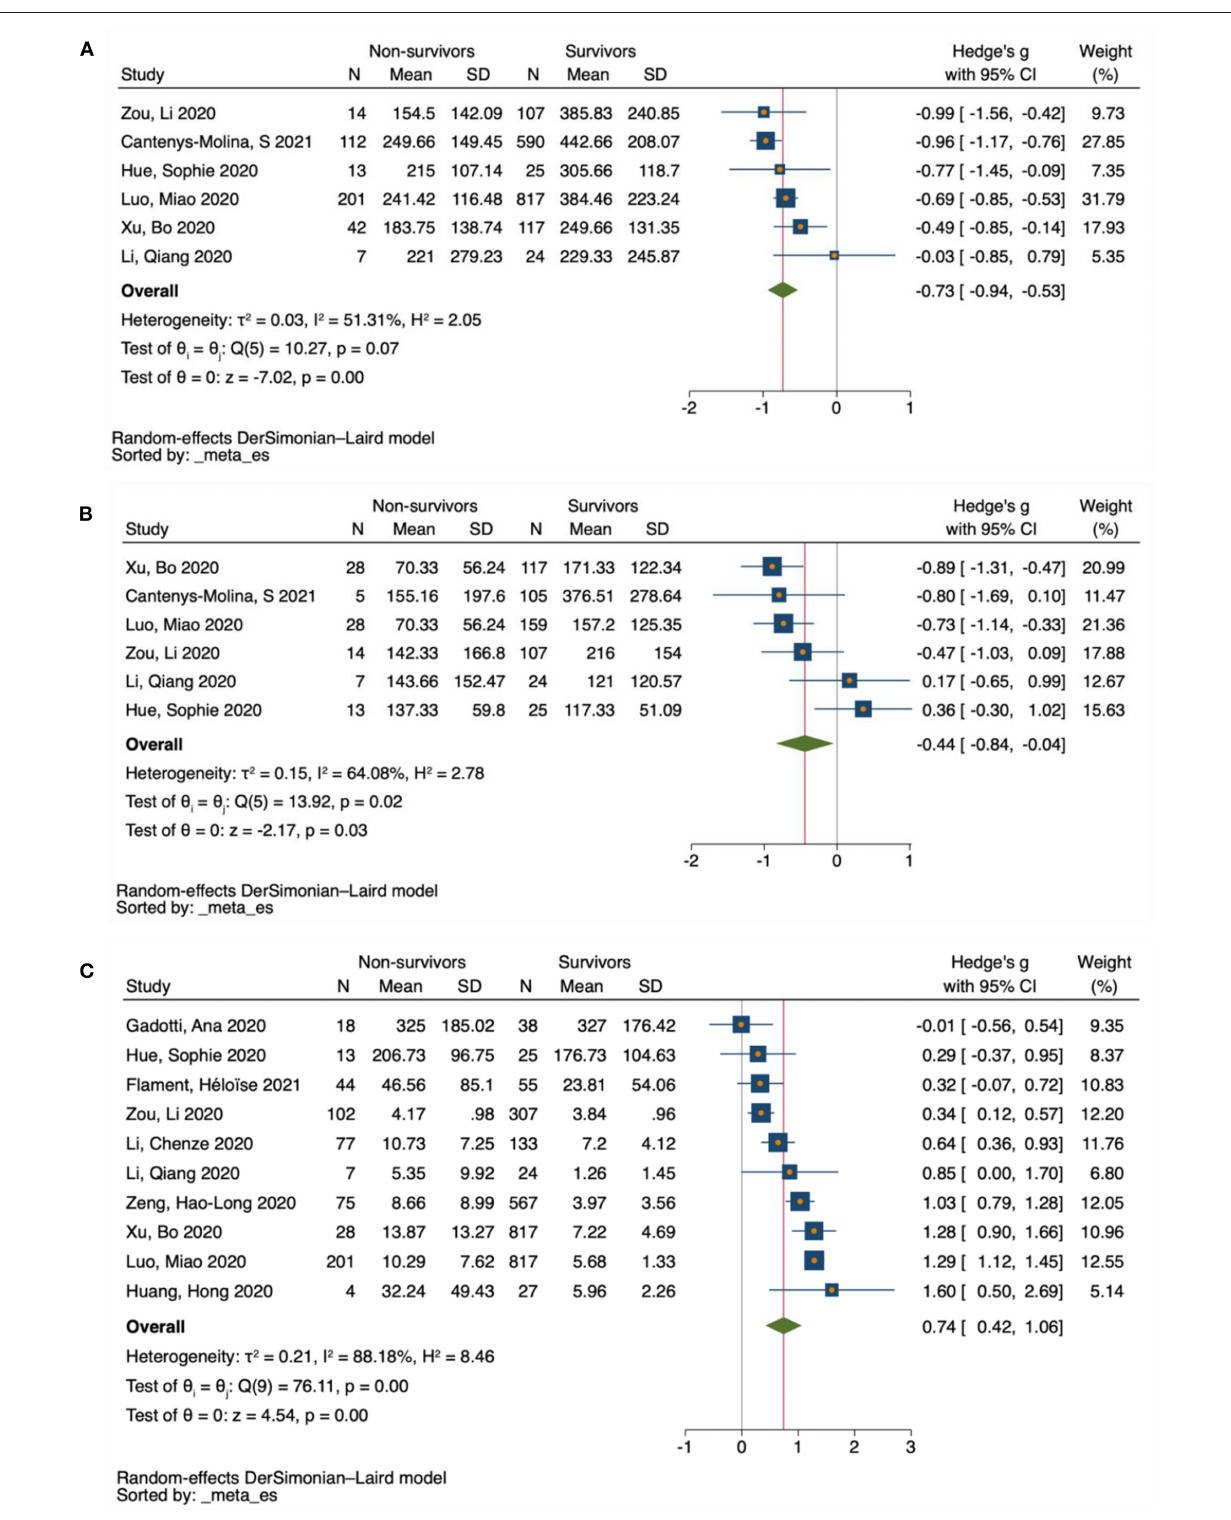
Frontiers in Medicine |